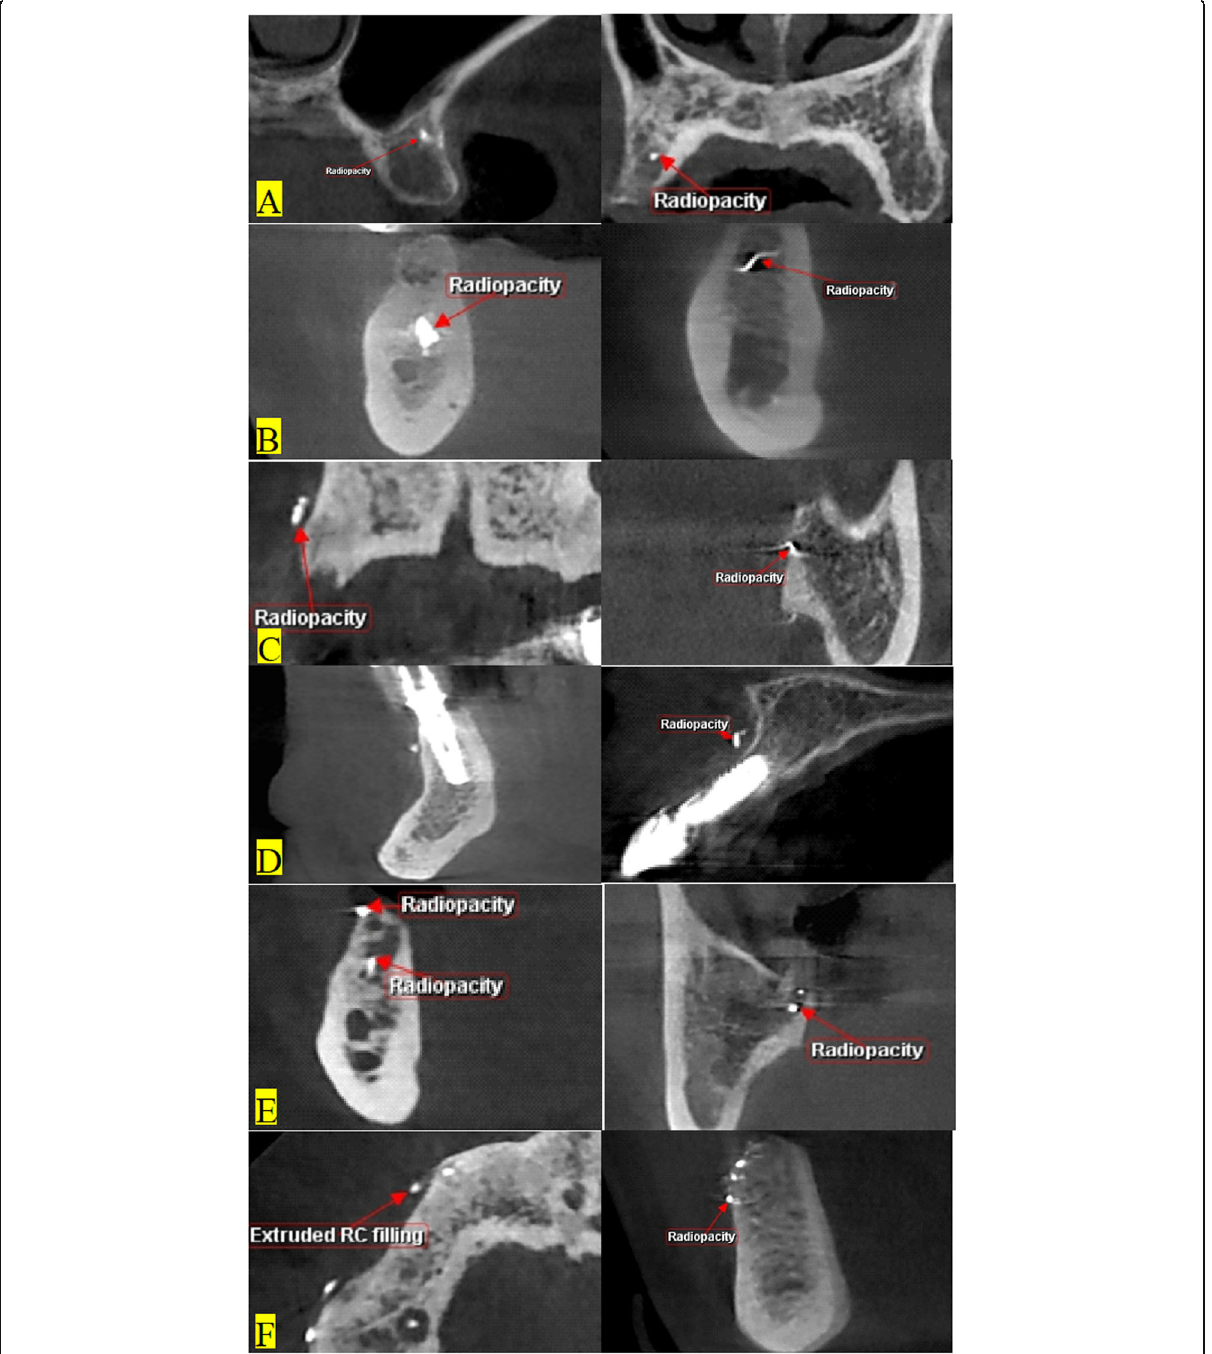
Fig. 2 Different forms of remnants of endodontic fillings radiopacities related to extraction sites: a small radiopacity deep in maxillary extraction sites, b radiopacities in mandibular extraction sites with or without evidence of tissue reaction, c remnants of filling radiopacities at the periphery of bone in maxilla and mandible, d radiopacities near implant sites in mandible and maxilla, e two radiopacities in the same extraction site, f more than 2 radiopacities in different sites or in the same extraction